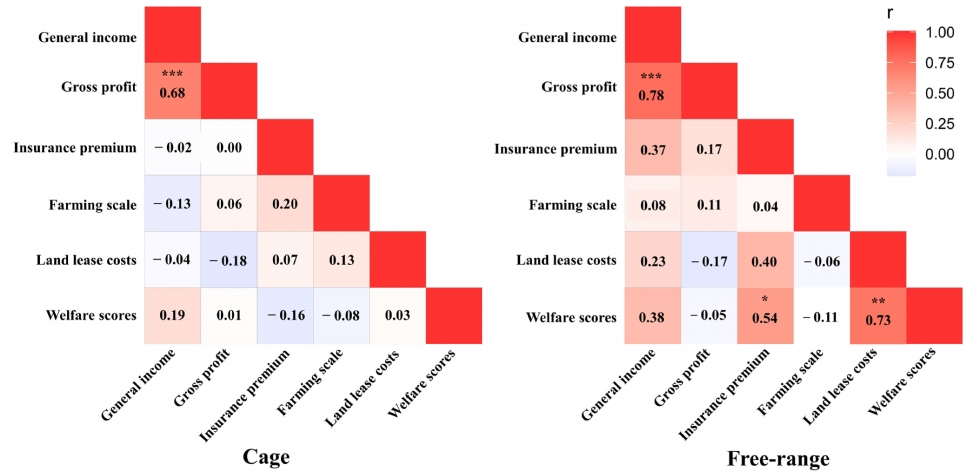
Figure 8. Spearman’s correlations between economic data and overall welfare scores of cage and free-range egg production farms. Note: Significant differences are denoted by * p < 0.05; ** p < 0.01, and *** p <